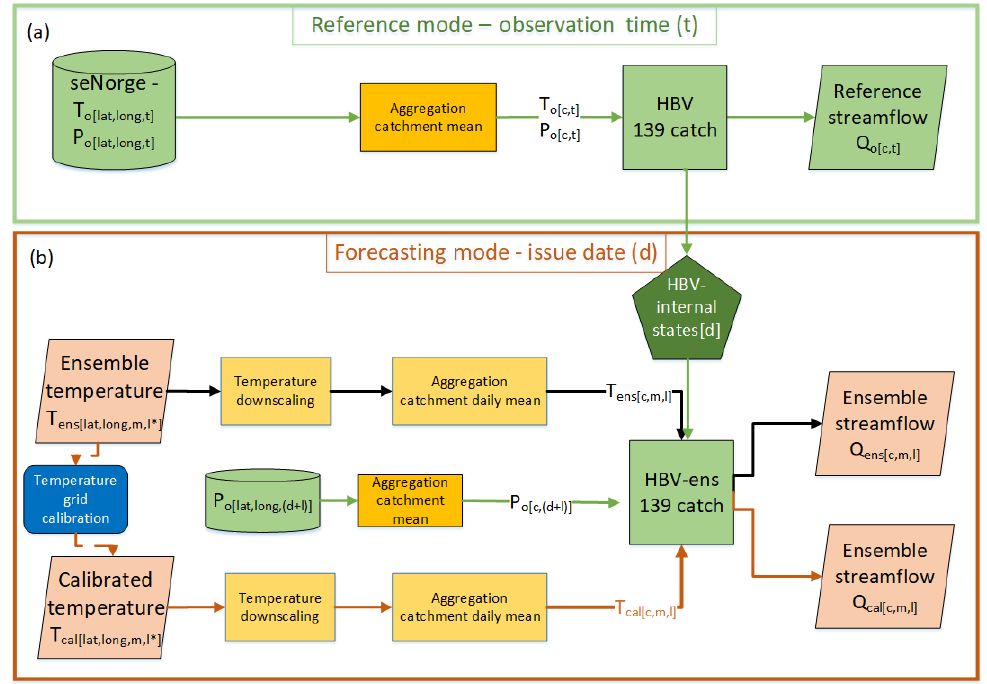
Figure 2. Conceptual diagram of the ensemble forecasting chain. Panel (a) shows the reference mode that is the calculation of reference streamflow using the HBV model with catchment aggregated daily mean values of seNorge temperature ( T o ) and precipitation ( P o ). In the forecasting mode (b) , ECMWF temperature ensembles are downscaled to 1km × 1km prior to catchment aggregation. Calibrated temper- ature ( T cal ) is estimated from T ens , applying a grid calibration at 5km × 5km resolution. Daily average forecast values ( T ens or T cal ) and observed precipitation ( P o ) are used to force the hydrological model at the forecasting issue date ( d ), with internal states from the reference